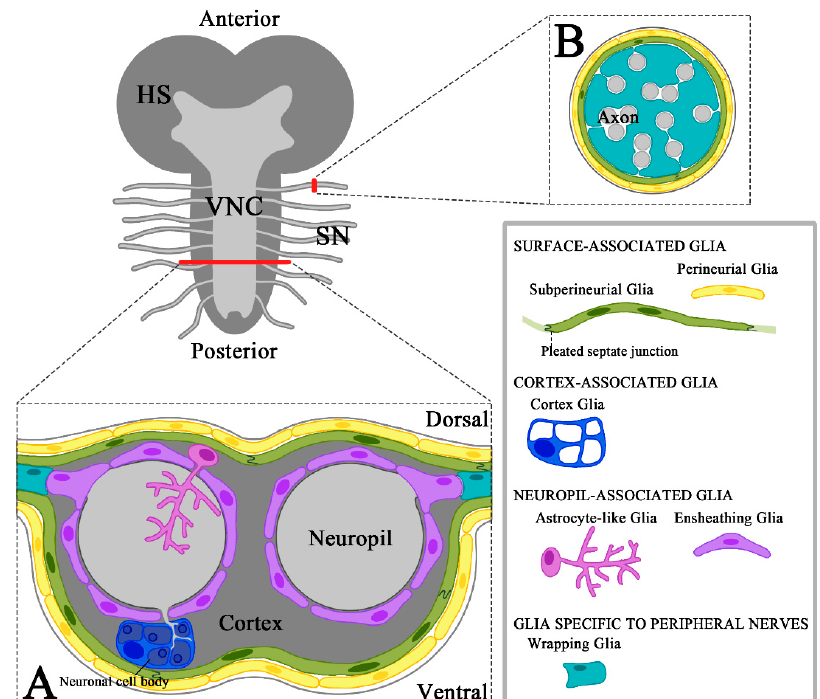
Figure 1. Glial cells of the Drosophila larval CNS. The Drosophila CNS is composed of two hemispheres (HS) and the ventral nerve cord (VNC). Segmentally organized nerves (SN) connect the VNC to the peripheral nerves. ( A ) Cross-section of the VNC. Glia in the Drosophila brain comprise three subtypes: surface-associated glia, cortex-associated glia, and neuropil-associated glia. Surface-associated glia act as a barrier for the CNS. Among them, the subperineurial glial cells form the intercellular pleated septate junction, which blocks paracellular transport and, thus, seals the nervous system from the hemolymph. During larval development, polyploidization takes place in the subperineurial glial cells. Cortex-associated glia wrap all neuronal cell bodies located in the cortex. Ensheathing glia and astrocyte-like glia are included in the neuropil-associated glia. ( B ) Cross-section of the SN at the periphery. Surface-associated glia cover the surface of the SN. Bundles of axons are wrapped by wrapping glia.